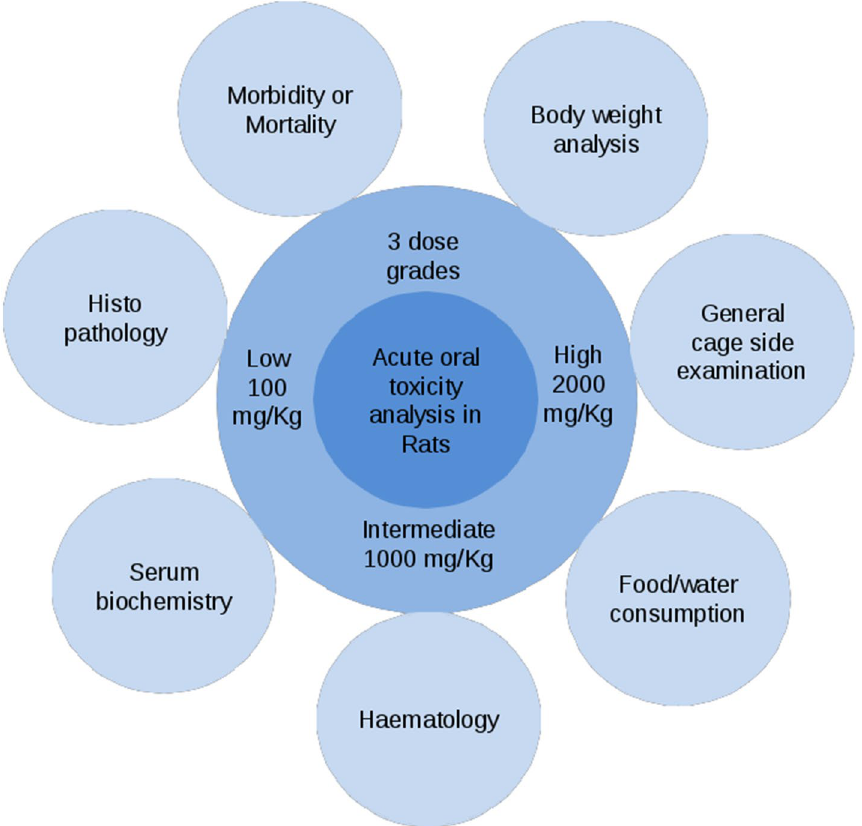
Figure 3. Schematic representation showing route followed for acute dose toxicity analysis following Disarib treatment in Wistar rats. 100, 1000 and 2000 mg/kg dose grades represents low, medium, and higher dose, respectively. Mortality, body weight, general cage side examinations, food and water consumption were analyzed everyday during the experiment. Haematology, serum biochemistry, and histopathology were analyzed after 14 days of dose